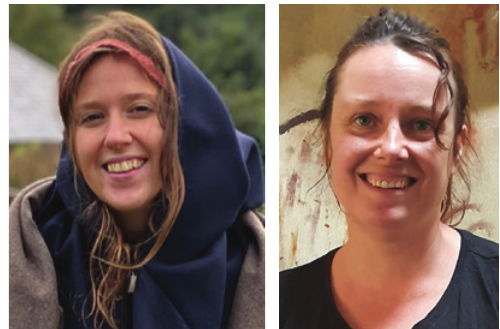
Figure 9 ASE team members Wiki Krzoska (left) and Letty Ingrey (right) at Archaeo-Tech (Source: photograph by ASE)